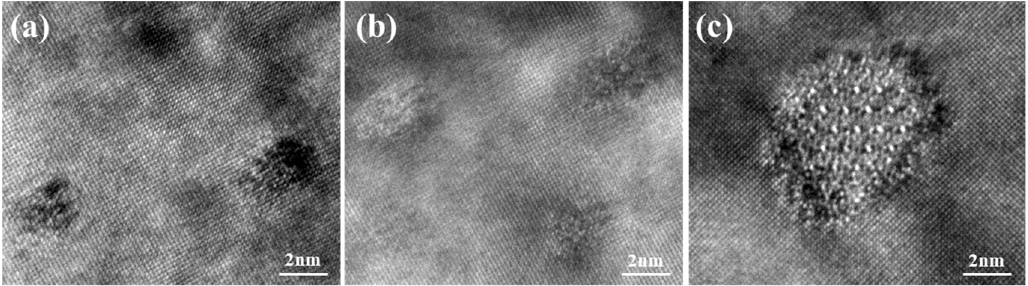
Figure 9. Transmission electron microscopy (TEM) images of the sample after experiencing different ageing treatments: ( a ) 160 °C at 600 min, ( b ) 175 °C at 480 min, ( c ) 190 °C at 180 min.